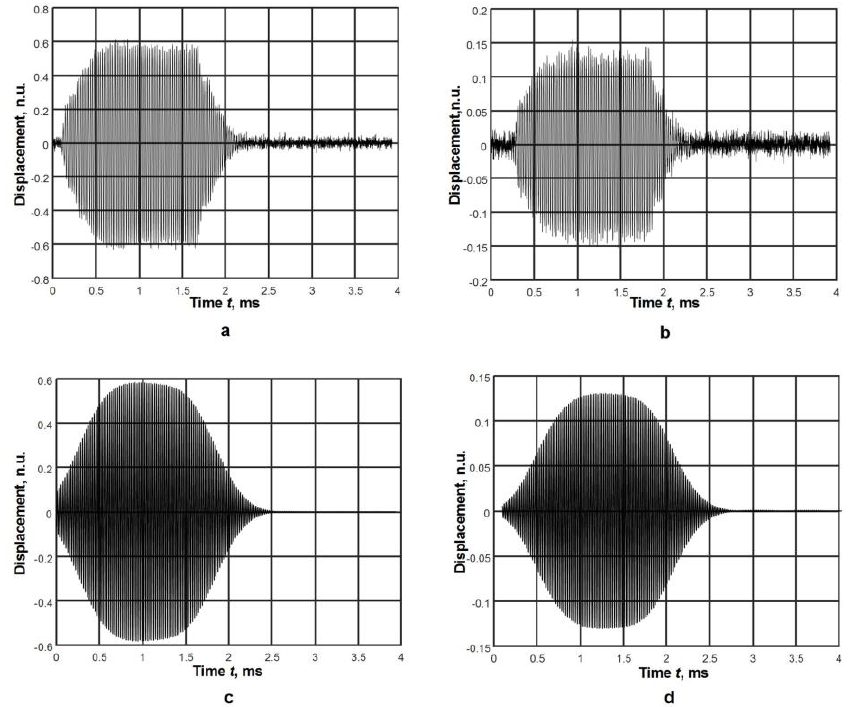
Figure 12. Raw ( a ) and ( b ) and filtered ( c ) and ( d ) A-scans at different distances from the piezoelectric transducer: ( a ) and ( c ) the distance is x j = 20 mm, ( b ) and ( d ) the distance is x j = 60 mm.